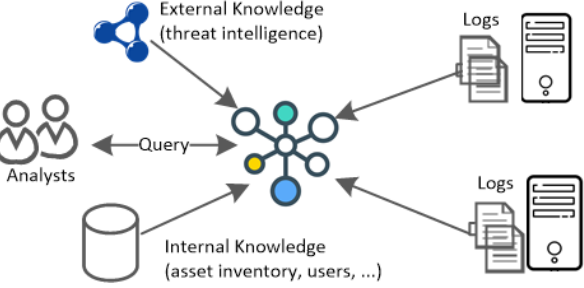
Figure 2. Concept